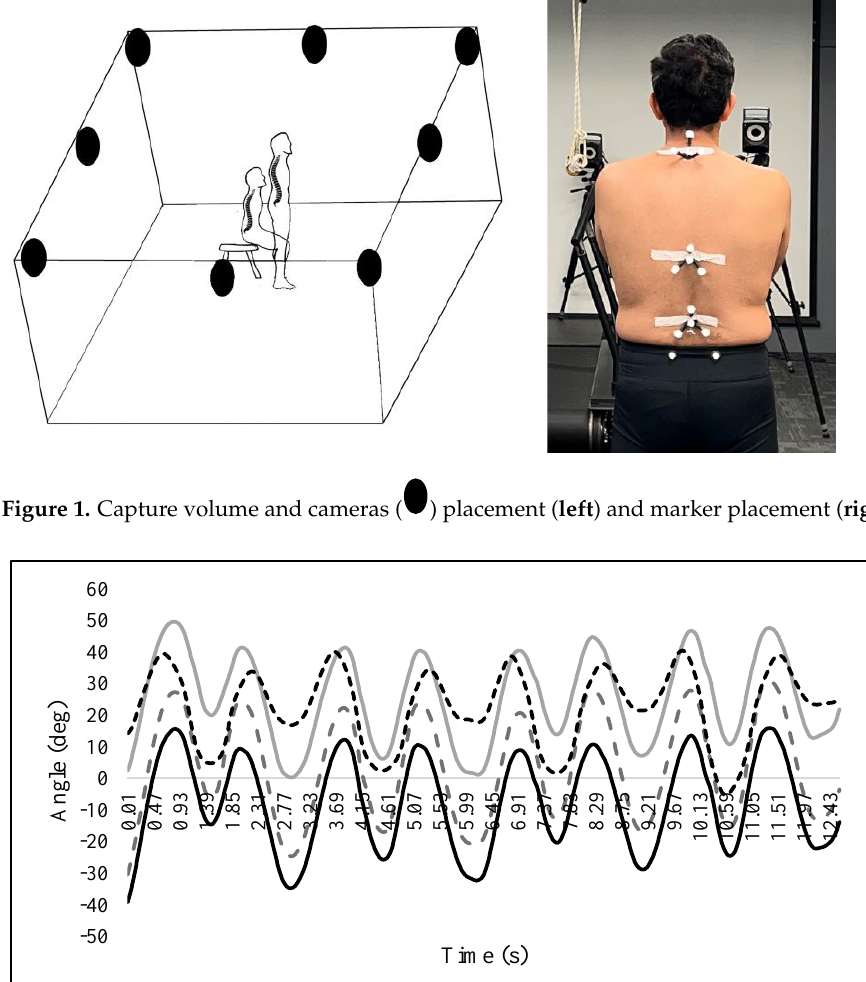
Figure 1. Capture volume and cameras ( ) placement ( left ) and marker placement ( right ).